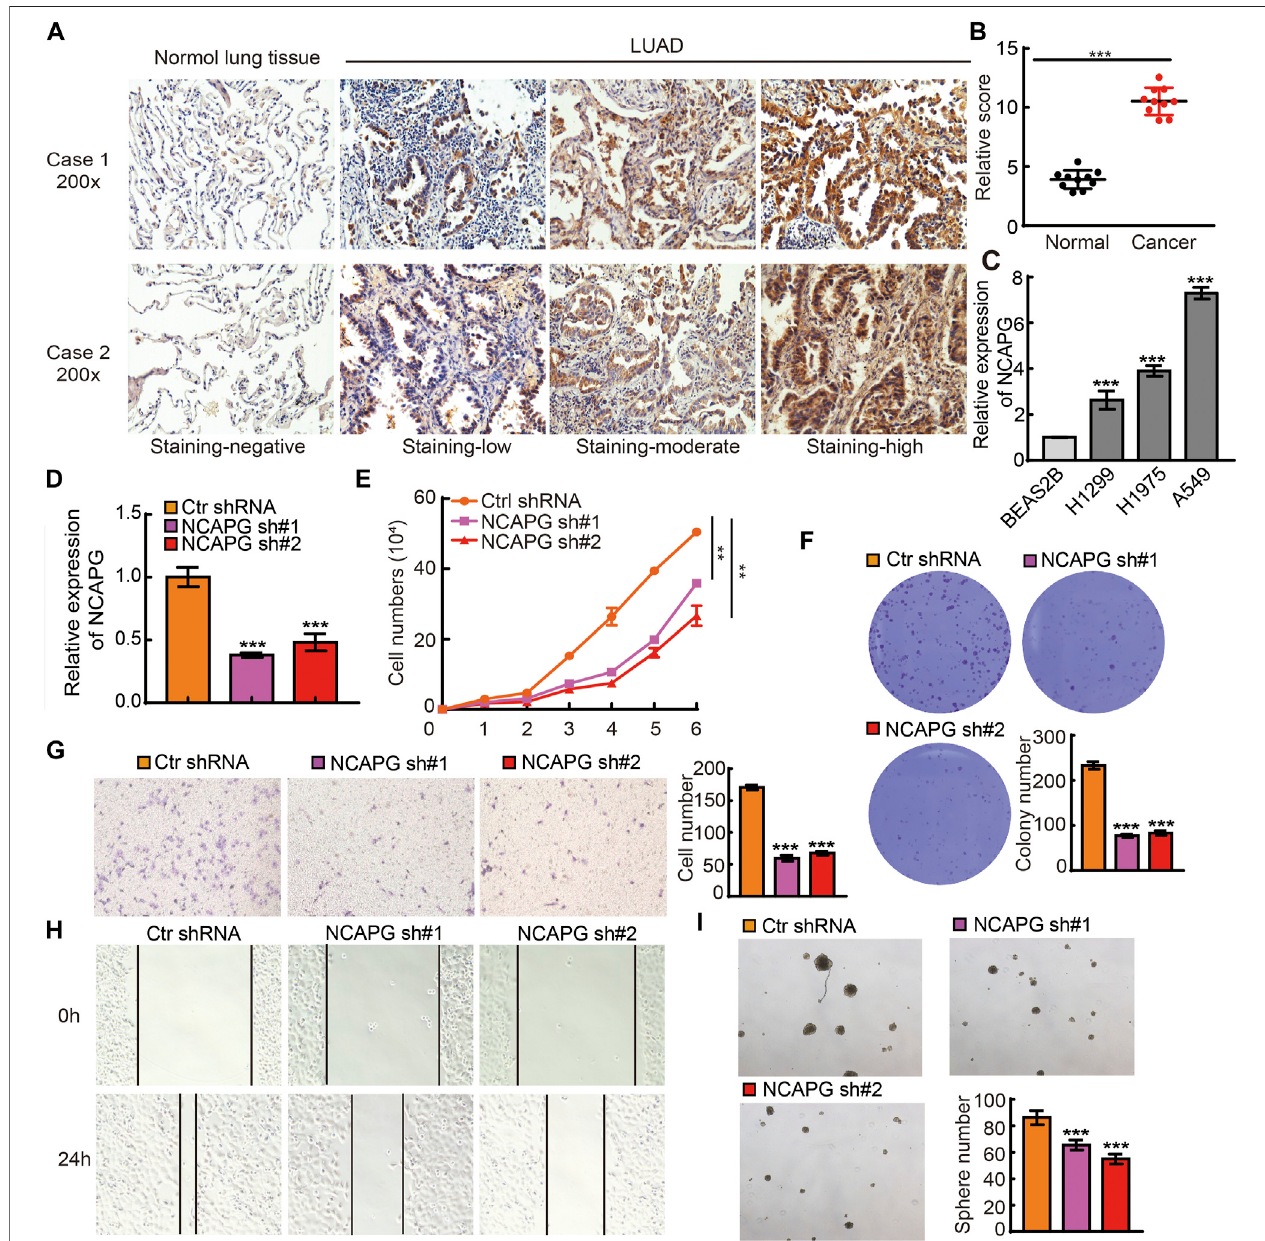
FIGURE 9 | NCAPG silencing on cell on proliferation, migration, and self-renewal ability of NSCLC Cell. (A) IHC analysis of NCAPG in lung cancer tissues and normal tissues. (B) IHC scoresstatistical analysisofNCAPG in lung cancer tissues and normal tissues. (C) The expression ofNCAPG in NSCLC celllineswasexamined byqRT-PCRassay. (D) The establishment ofNCAPG knockdown inA549celllines and veri fi edbyreal-time qPCR (E,F) Growth curveand clone formation assayswere utilized to detect silencing of NCAPG on the growth of A549 cell. (G,H) Transwell and wound healing assays were used to detect silencing of NCAPG on the migration of A549 cells. (I) A tumorsphere experiment was used to detect silencing of NCAPG on the self-renewal of A549 cells. * p < 0.05, ** p < 0.01, *** p < 0.001.